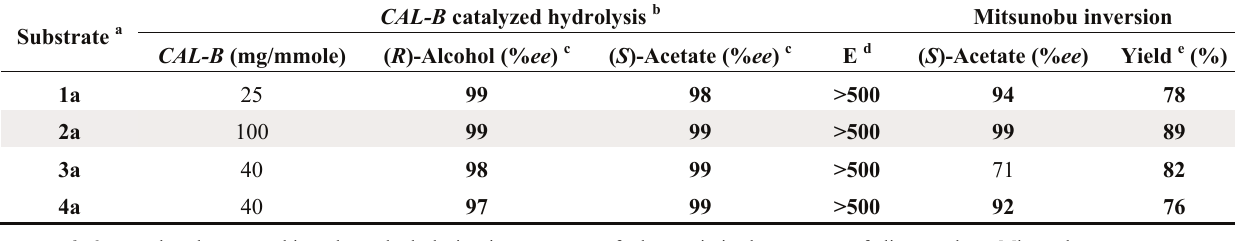
Table 2. Deracemization of acetates 1a – 4a through a resolution/inversion process. The shadowed line emphasize the best result in terms of enantiomeric excess and yield.